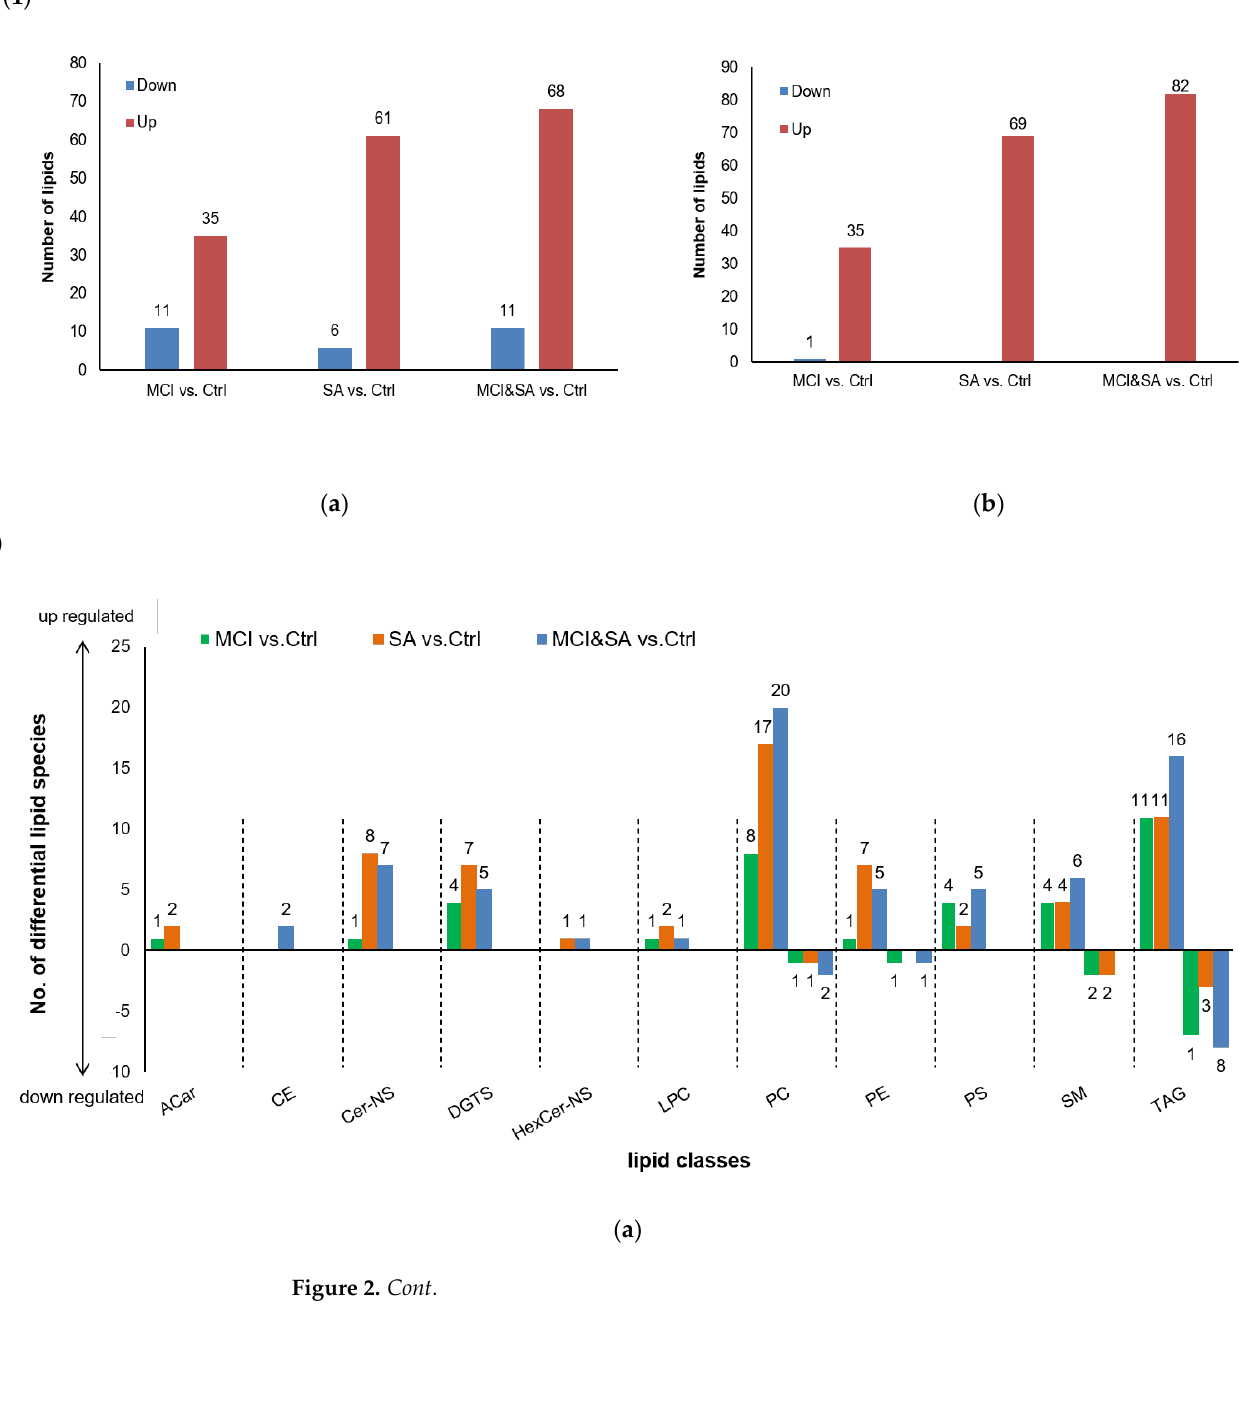
( b ) Figure 2. ( 1 ) Number of lipids with significant changes in different comparisons ( VIP > 1, p < 0.05). ( 2 ) Number of differential lipid species according to ( 1 ) in (a) positive and (b) negative ionization mode. CE, cholesteryl ester; Cer, ceramides; DGTS, diacylglyceryltrimethylhomoserine; FA, fatty acids;